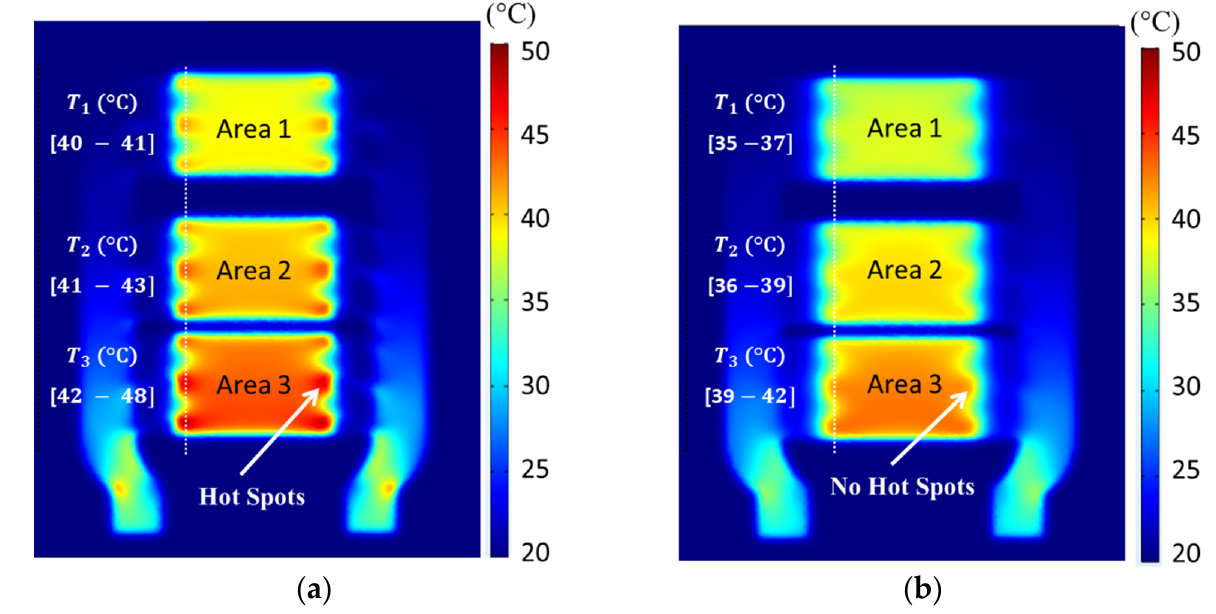
Figure 6. Influence of the thermal conductivity ( λ ) on the numerical heatmap of the tablecloth set: ( a ) λ carbon and λ copper values shown in Table 3; and ( b ) λ carbon = λ copper = 10 W.m − 1 .K − 1 . Another solution relies on optimization of the coating design, as previously described in Section 3.1. In reality, more than 300 patterns were investigated to determine the most appropriate candidate fulfilling the requirements. For the sake of simplicity, only three rep- resentative designs are shown and compared, as illustrated in Figure 7. Here, D0, D1, and D2 correspond to the initial design (Figures 6b and 7a), design 1 (Figure 7b), and design 2 (Figure 7c), respectively. As opposed to D0, D1 allows for a significant reduction in the number of hot spots, but the temperatures of the three areas are still not homogeneous. Remarkably, D2 (the most optimized design) definitively solves these two problems, and thus will be used for the development of a real prototype (cf. Sections 4.4 and 5.4).